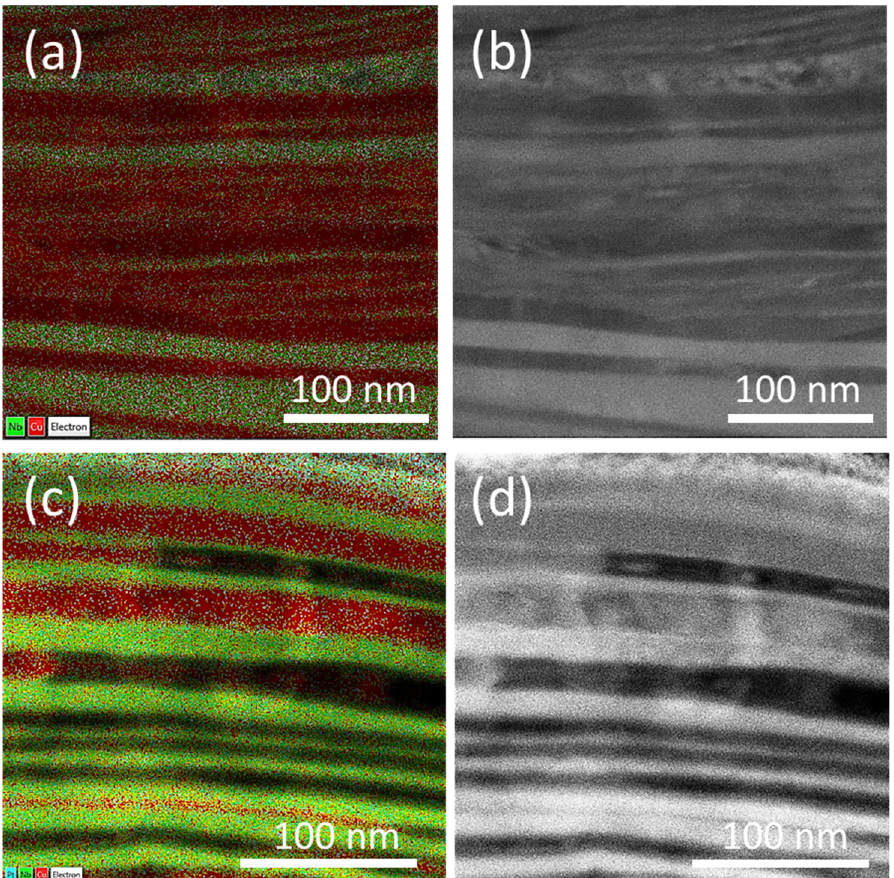
Figure 11. TEM + EDX image (red = Cu, green = Nb) of the representative Cu(16)/Nb(16) ARB nanolaminate ( a , b ), EDX and TEM for RD. TEM shows a possible fracture of the nanolayers (most likely Nb) due to the inhomogeneous deformation, and the other element (most likely Cu) starts filling the cavity in the broken nanolayers. This leads to the formation of layers into one large band (mostly red-colored in ( a ); about as thick as 5–8 typical individual nanolayers in this sample) as evident in the EDX image ( a ), instead of the layer-by-layer structure typically found in fabricated Cu(16)/Nb(16) ARB samples, or what is shown in images ( c , d ). ( c , d ) EDX and TEM for nanolayers representative of TD samples consisting mostly of layer-by-layer structures that are maintained due to more homogenous deformation.